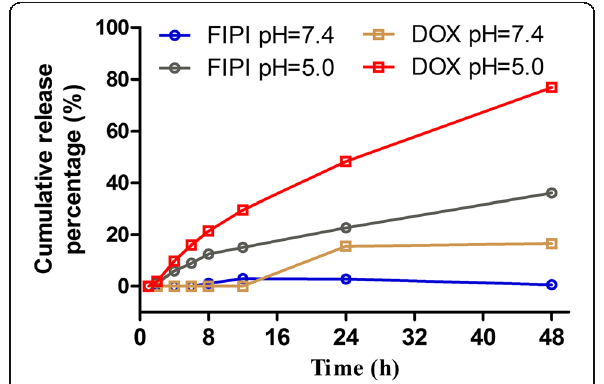
Fig. 2 In vitro release profiles of FIPI and DOX from DFT-lip